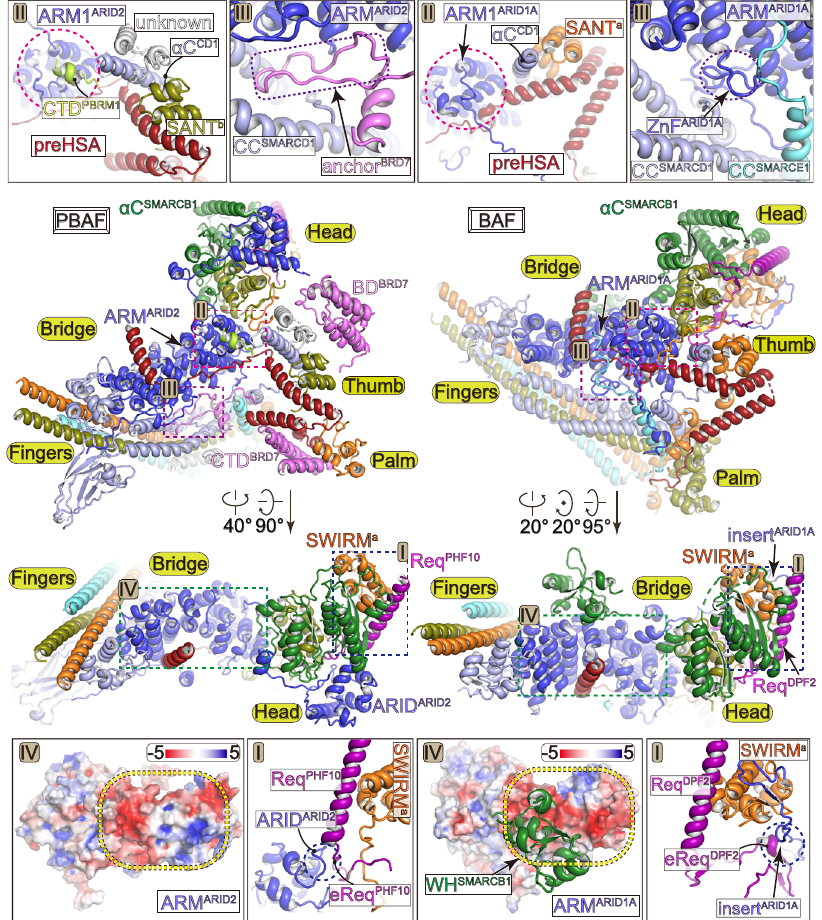
Fig. 3 | PBAF-speci fi c organization of the Base module. Comparison of the Base modules of PBAF (left panels) and BAF (right panels) in two different views. Structuraldifferencesatregion-Itoregion-IVareindicatedonoverallstructureand